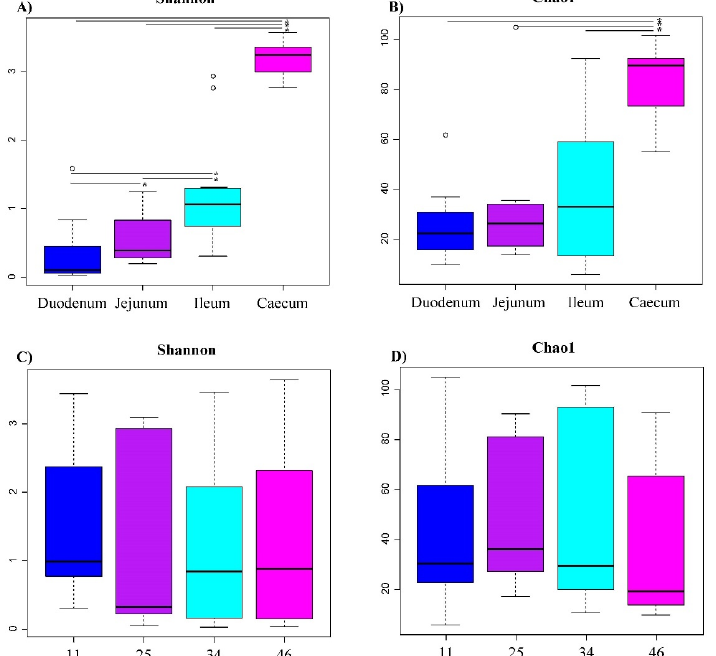
Figure 2. Alpha diversity analysis by intestine segment ( A , B ) and age ( C , D ). Diversity within samples is estimated by the Shannon diversity index and richness estimator Chao 1. Only significant pairwise comparisons ( p -value < 0.05) are shown (*). The distribution of genera in the intestine segments was statistically significant (Ado- nis test, p -value = 0.0017; Figure 3). It is remarkable to observe a clear separation of caecum from the other segments (first CCA component) and a second CCA accounting for a dif- ference between ileum from jejunum and duodenum (Figure 3). Similar results were ob- tained after applying weighted and unweighted PCoAs, particularly the caecum separa- tion from the other intestine segments (Supplementary Figure S4).